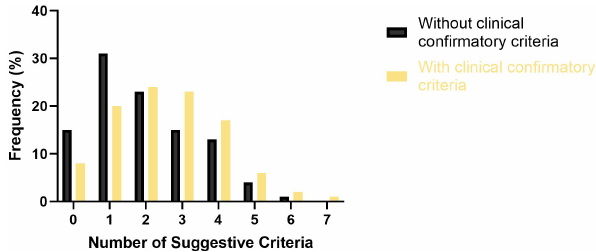
Figure 1. Number of clinical suggestive criteria per